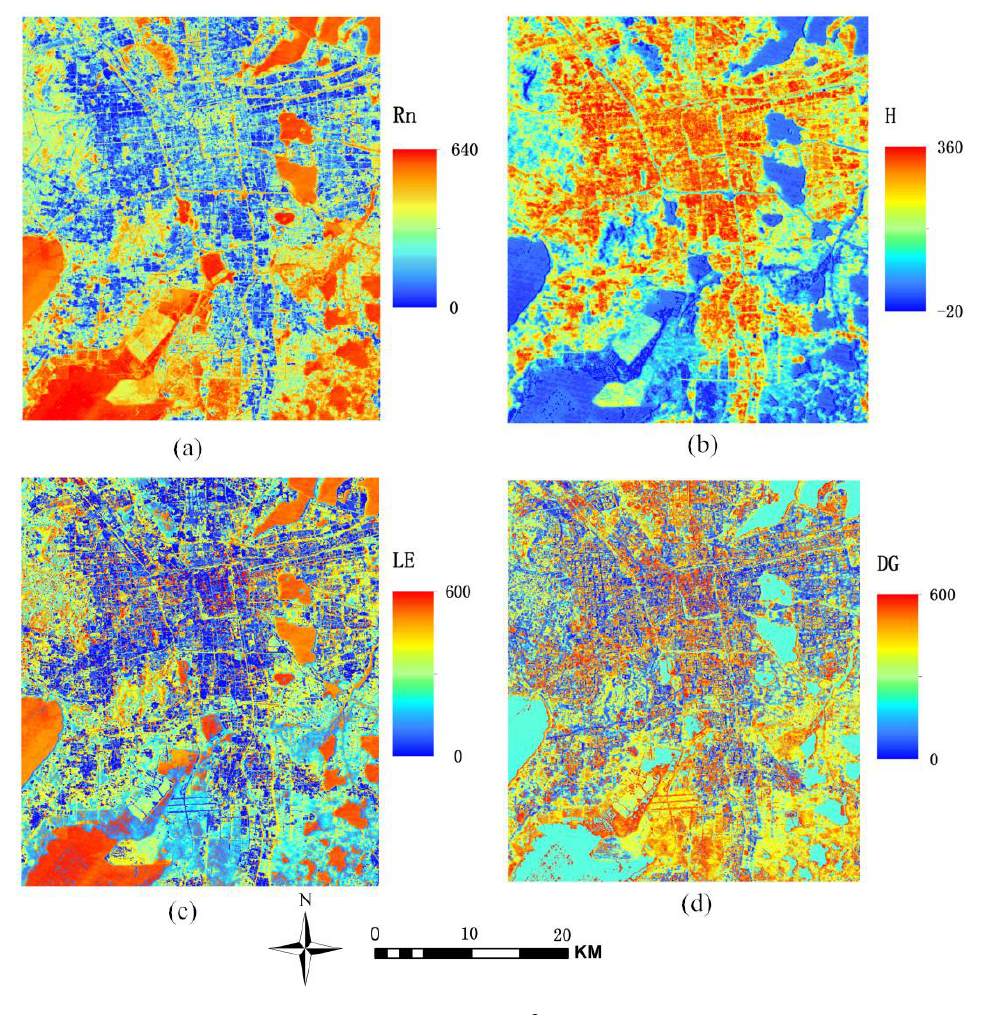
Figure 6. The distribution maps of heat fluxes (in Wm −2 ) at 1040 LT, estimated with 30-m LANDSAT- 5 TM acquired on 24 May 2010. ( a ) Net radiation, Rn; ( b ) sensible heat flux, H; ( c ) latent heat flux, LE; and ( d ) storage heat flux, DG.